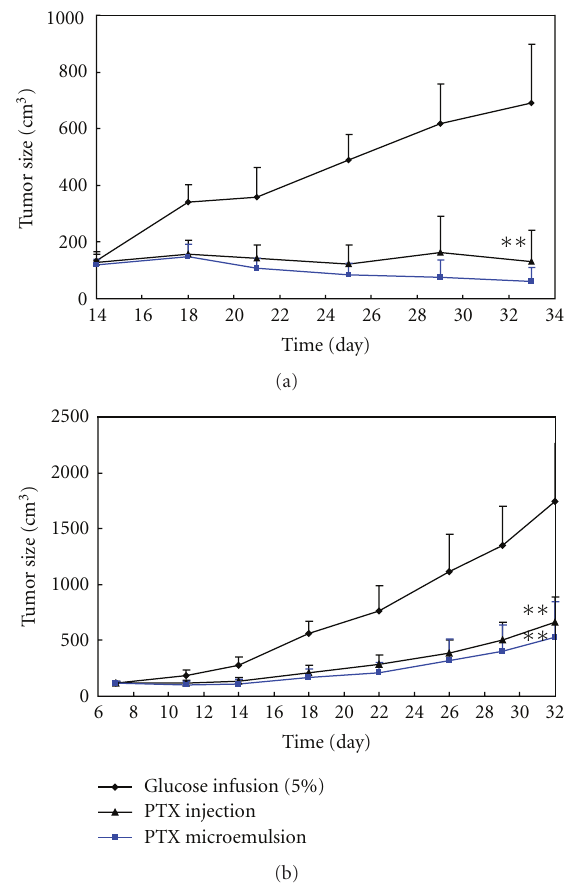
Figure 4: Tumor growth inhibition by PTX injection or PTX microemulsion. BALB/C mice were inoculated s.c. with OVCAR- 3 cells (a) or A-549 cells (b) and treated with 5% glucose, PTX injection or PTX microemulsion (15mg/kg, i.v., q4d4, every 4 days for four doses), respectively. Tumor size was measured with calipers twice per week. Results are given as means ± S.D. ( n = 6). ∗∗ P < . 01 versus 5% glucose infusion as